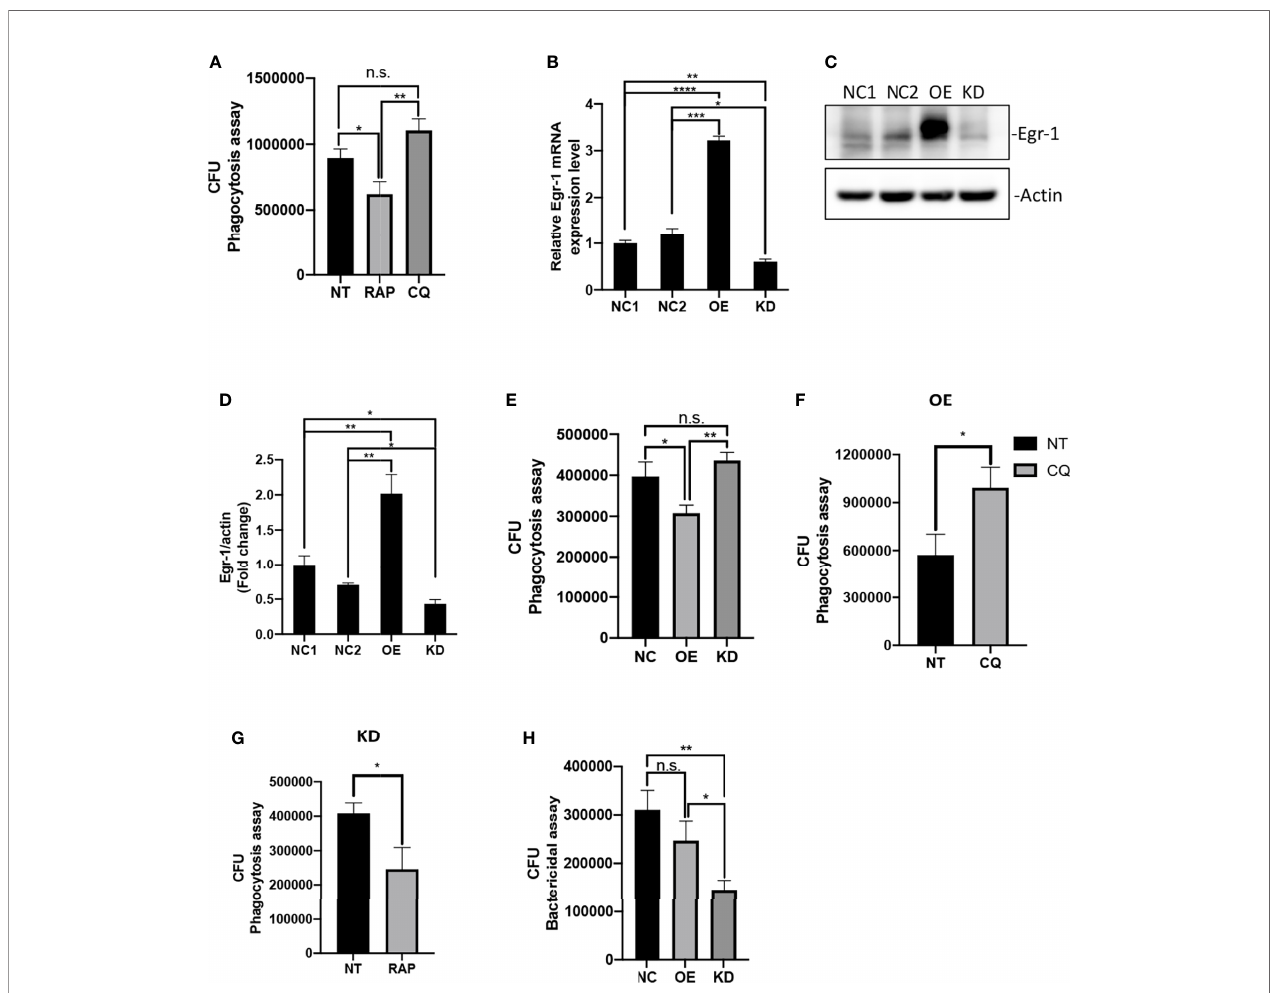
FIGURE 2 | Egr-1 suppressed the phagocytosis of P. aeruginosa by macrophages. RAW264.7 macrophages were pretreated with 200 nM rapamycin (RAP) or 20 µM chloroquine (CQ) for 1 h or left untreated (NT). These cells were infected with P. aeruginosa PAO1 at an MOI of 20 for 1 h and lysed for phagocytosis assay (A) . The CFU data represented the number of internalized bacteria within 1 h (n = 6 ± SEM; n.s., not signi fi cant, *p < 0.05, **p < 0.01). The RAW264.7 macrophage cell lines with stable Egr-1 overexpression (OE) or knockdown (KD) were constructed via lentiviral transduction. The transduction ef fi ciency was assessed by real-time quantitative PCR and Western blot analysis. The Egr-1 mRNA levels in Egr-1 OE and KD cells as well as their negative controls NC1 and NC2 were normalized to endogenous control b -actin (B) (n = 3 ± SEM; *p < 0.05, **p < 0.01, ***p < 0.001, ****p < 0.0001). The blots for Egr-1 protein expression are representative of three independent experiments (C) . Densitometry analysis of Egr-1 protein levels was normalized to actin, and data are presented as fold change (D) (n=3 ± SEM; *p < 0.05, **p < 0.01). The Egr-1 NC, OE and KD RAW264.7 cells were infected with P. aeruginosa PAO1 at an MOI of 20 for 1 h and lysed for phagocytosis assay (E) (n = 6 ± SEM; n.s., not signi fi cant, *p < 0.05, **p < 0.01). The Egr-1 OE and KD cells were pretreated with 20 m M CQ and 200 nM RAP, respectively, for 1 h or leafed NT. Subsequently, these cells were infected with P. aeruginosa PAO1 at an MOI of 20 for 1 h and lysed for phagocytosis assay (F, G) . The P. aeruginosa